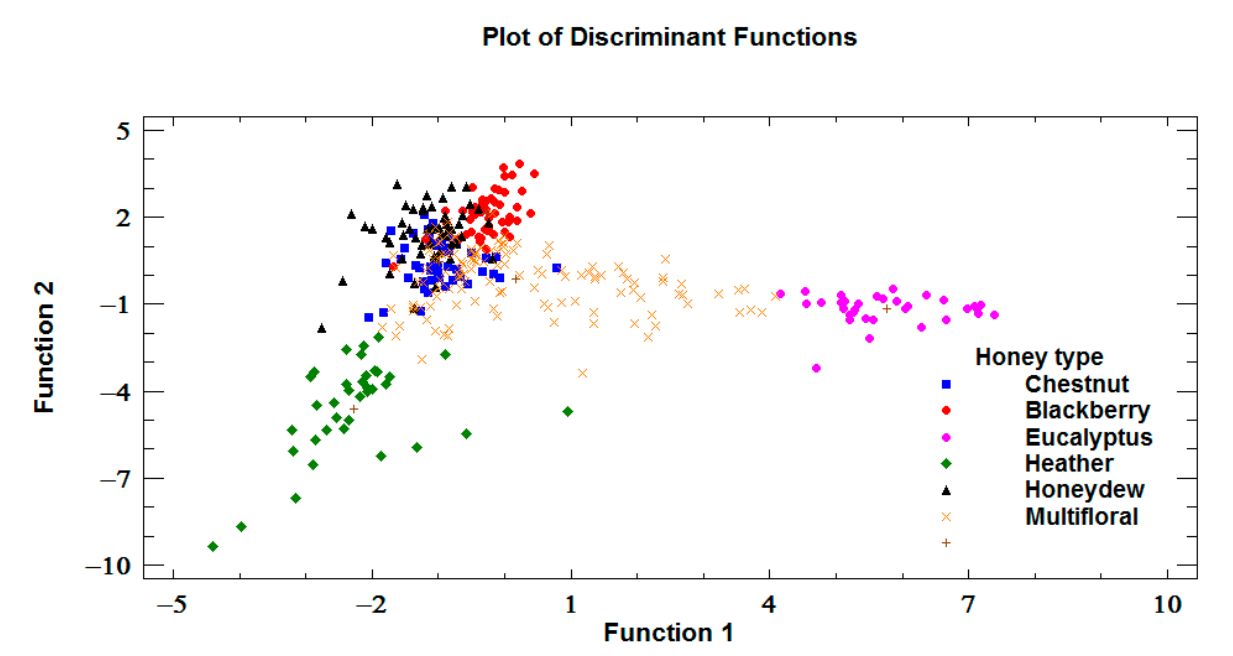
Figure 3. Plot of the representation of the first two discriminant functions and distribution of samples by honey type.